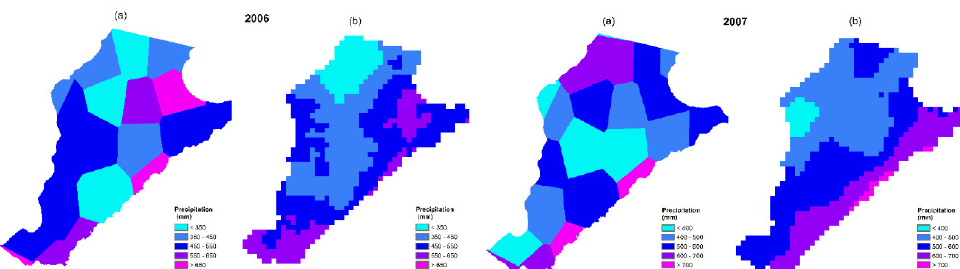
Figure 7. Spatial distribution of annual precipitation (mm) for year 2006 and 2007. ( a ) rain gauge measurements (Thiessen polygons); ( b ) based on remote sensing products which has been corrected.